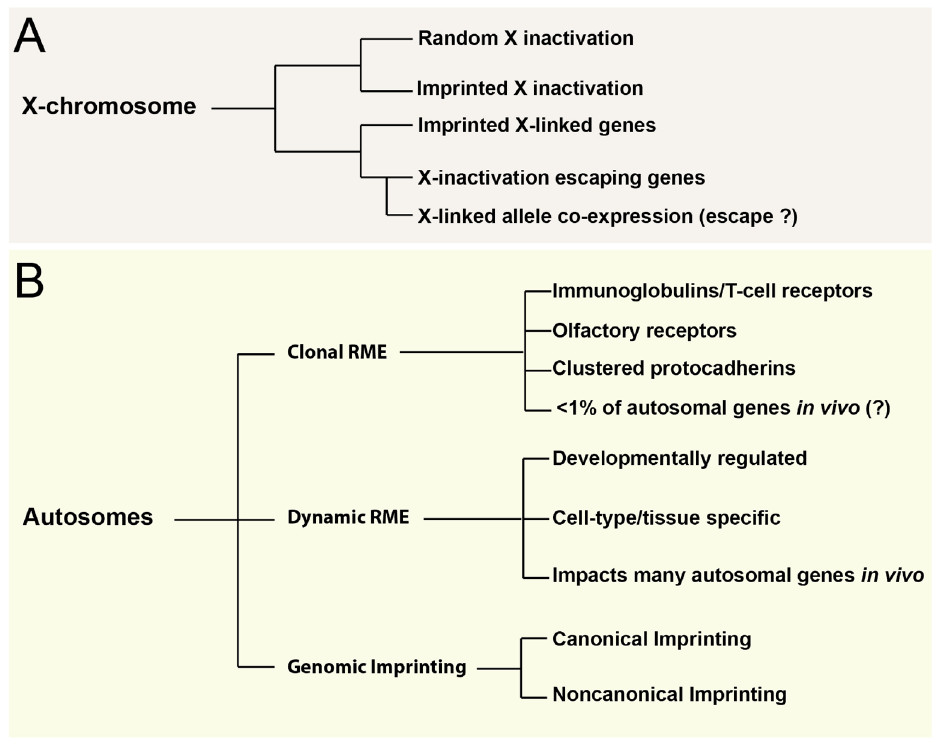
Figure 6. The current landscape of in vivo non-genetic allelic effects in mammals. ( A ) Non-genetic allelic effects that impact X-linked genes in females are shown. ( B ) Effects impacting autosomal genes are shown. Tissue- and age-specific allele co-expression effects for X-linked genes were observed by Huang and Ferris and colleagues 53 (2017), but the underlying cause is not yet known. Additionally, the frequency of clonal random monoallelic expression (RME) effects in vivo is debated and requires further